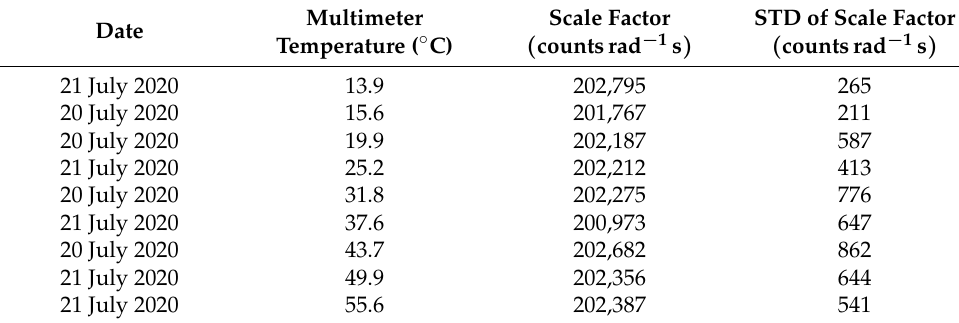
Table 7. Average temperature measured at each temperature step with the average tilt table scale factors of component HJY and standard deviations of the scale